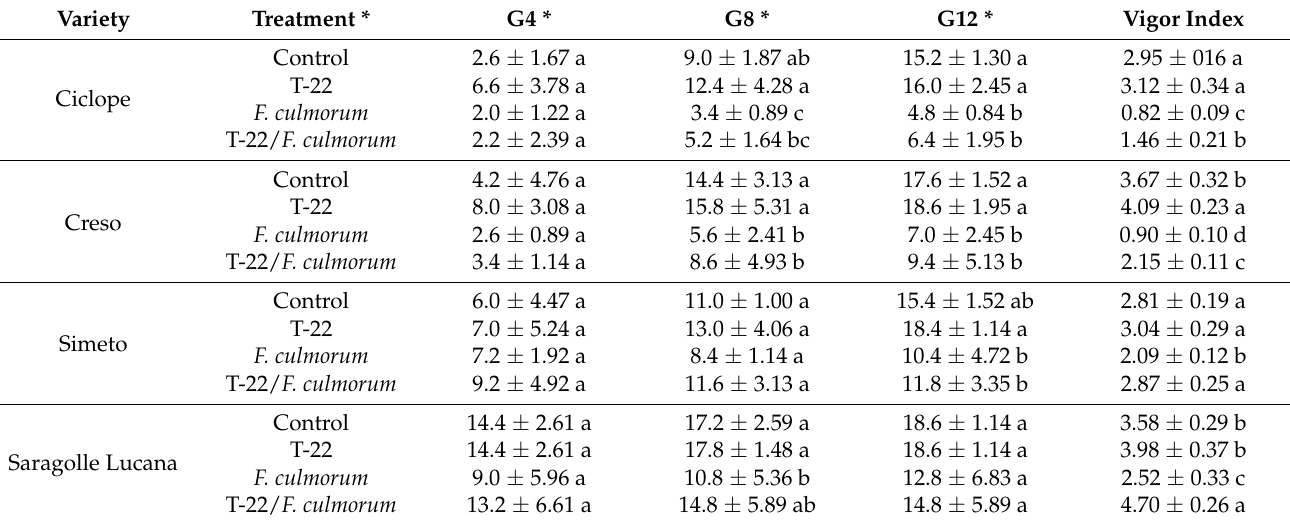
Table 3. Germination and speed of emergence (vigor index) in the four Italian tetraploid durum wheat seeds treated with Trichoderma harzianum T-22 and sown in a substrate with F. culmorum . Variety